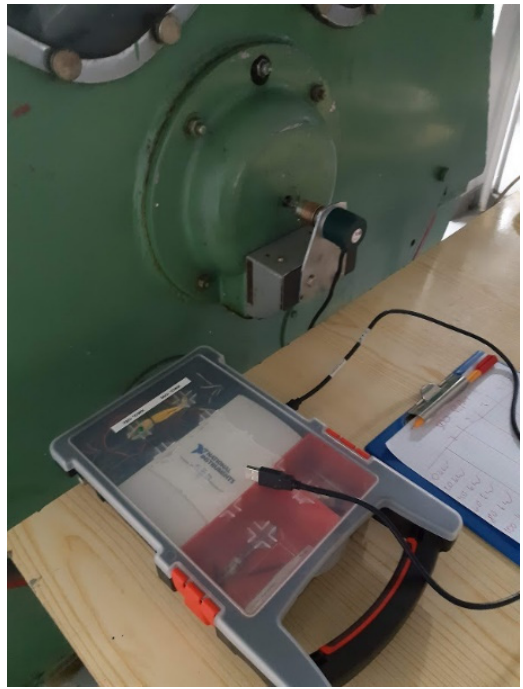
Figure 3. View of the BAH engine with a connected measuring device.